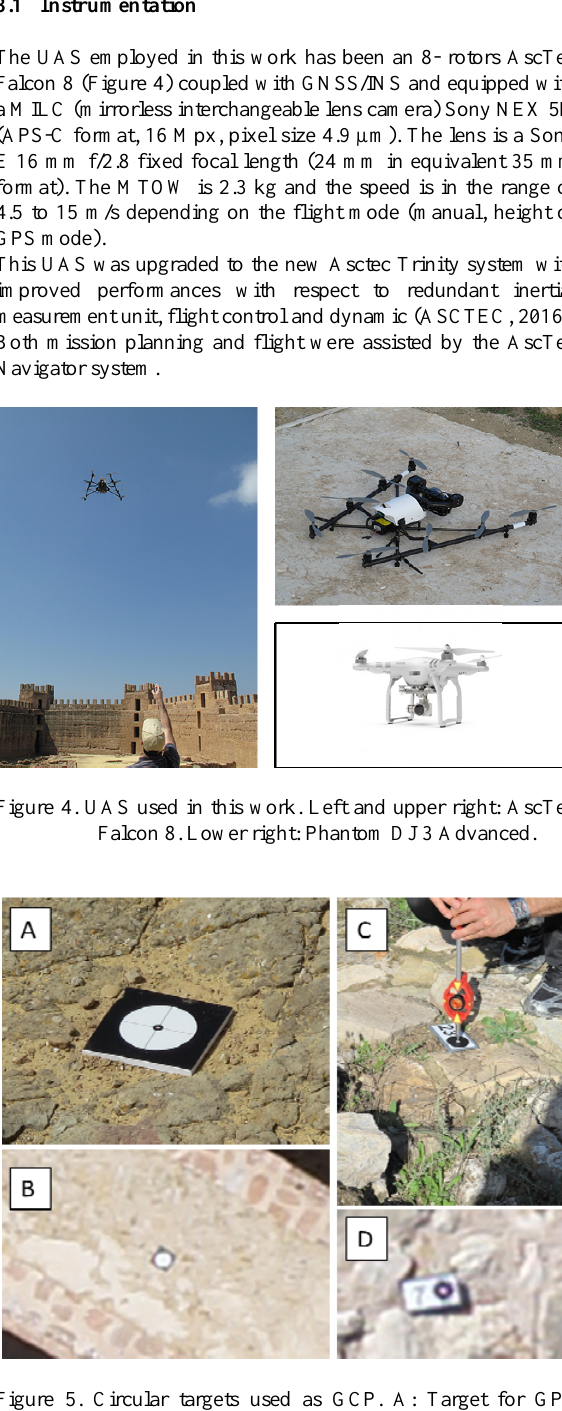
Figure 6. Network geometry at Burgalimar Castle (107 images). Upper: conventional vertical network (2 strips, 16 images). Lower: convergent and oblique network around the castle. Three strips at different height were planned (91 images). The image acquisition mode was